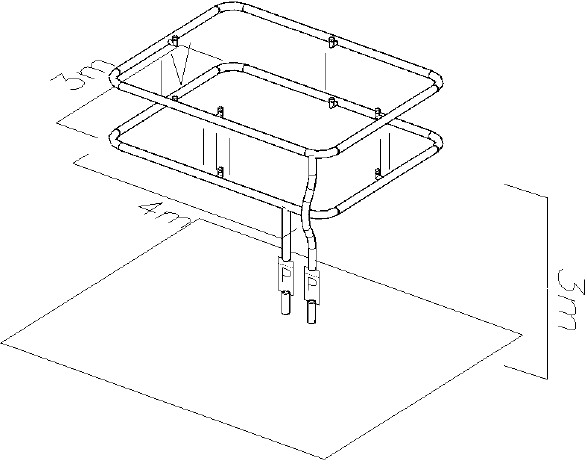
Fig. 1. Rain simulator, two layers with 8 Figure 1. Rain simulator, two layers with 8 nozzles 3